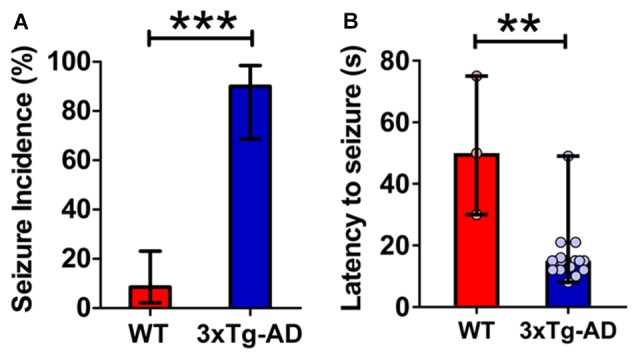
Increased propensity for audiogenic seizures in 3-week-old triple transgenic mouse model of familial Alzheimer’s disease (3xTg-AD) mice. (A) The incidence of convulsive seizures was markedly higher in 3xTg-AD mice (blue bar) compared to wild type (WT) mice (red bar). The data are presented as percent incidence with 95% confidence interval and compared using exact logistic regression stratified by litter. (B) The latency to seizure was significantly lower in 3xTg-AD mice as compared to WT control. The data are depicted as median with range, and analyzed using Mann-Whitney U test. **p < 0.01, ***p < 0.001, compared to WT. WT (n = 35) and 3xTg-AD (n = 20) mice.